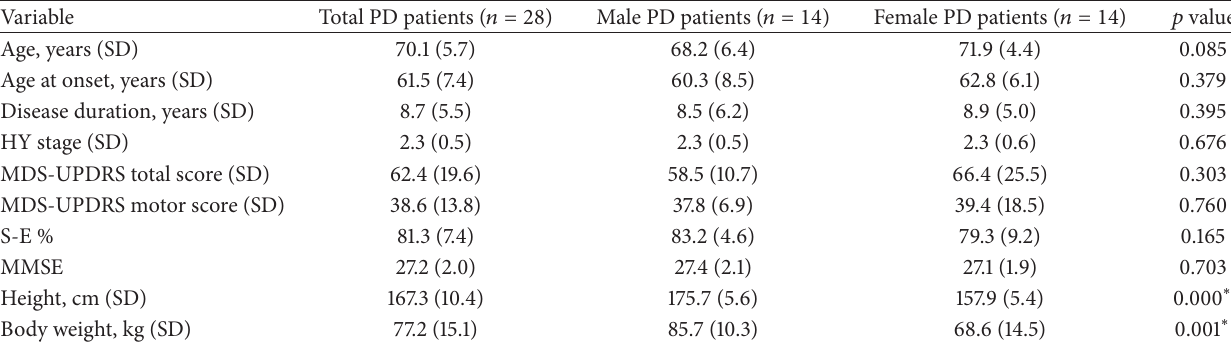
Table 1: General clinical and demographic characteristics of PD patients, subdivided for gender.